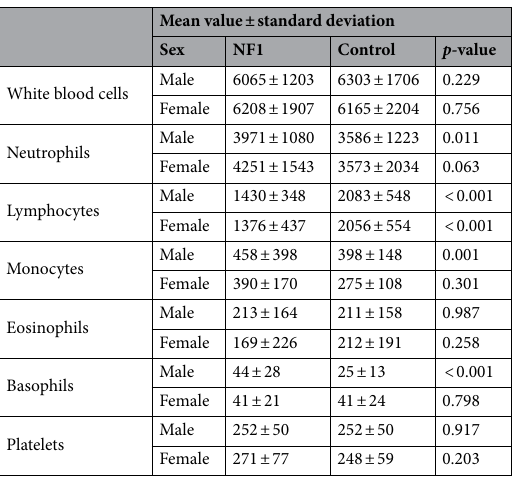
Table 1. Comparison of differential white blood cell counts between NF1 patients and